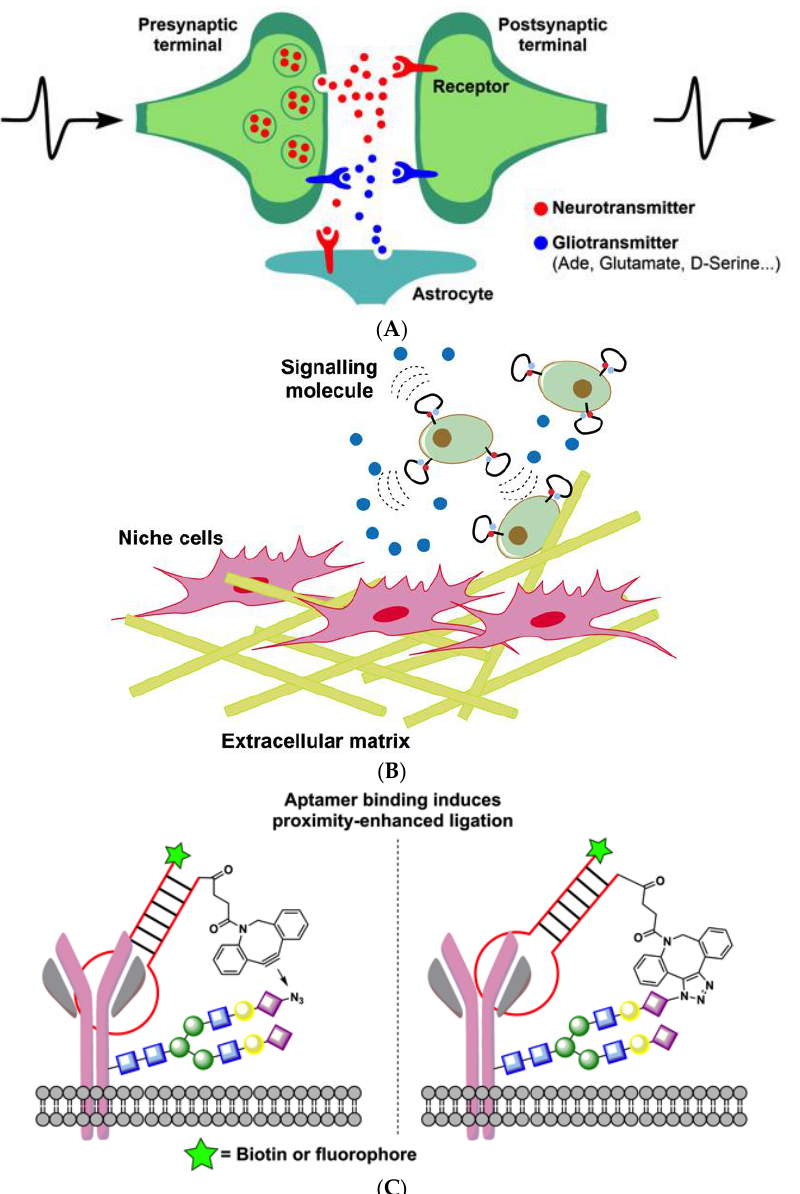
Figure 4. Aptamer-based molecular tools to probe cellular events. ( A ) Cell surface-anchored aptamer sensors to image chemical transmitter dynamics. Gliotransmitter adenine compounds in the form of ATP were detected using aptamer-based sensor [74]; ( B ) aptamer-based sensor immobilized on mesenchymal stem cell binding to probe signaling molecules secreted by niche cells [36]; ( C ) design of aptamer-based proximity ligation assays. Aptamer specific to cell-surface proteins utilized in detecting glycosylation patterns [75].